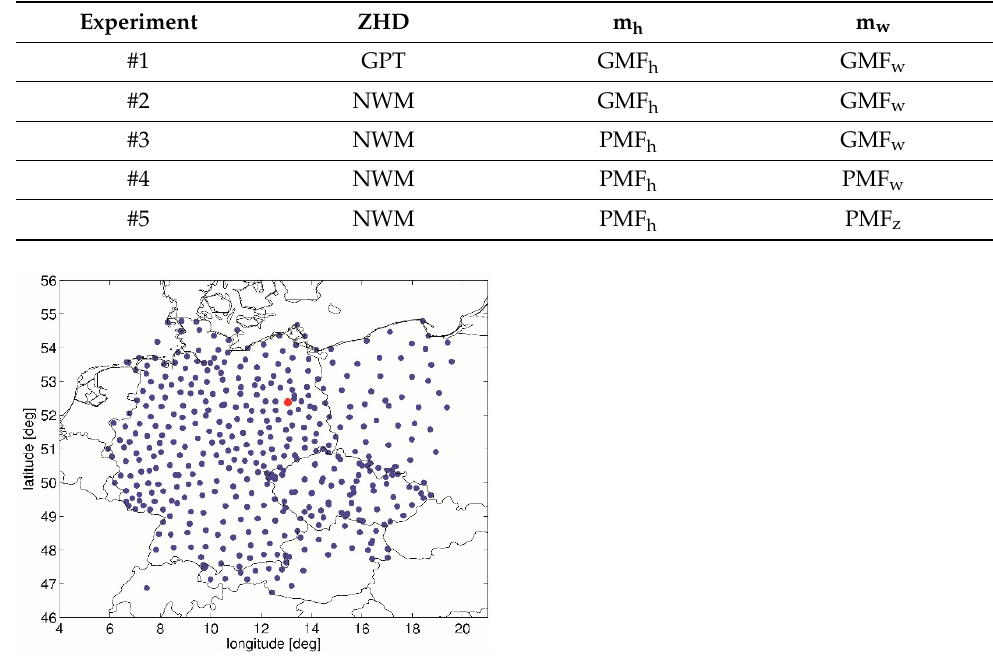
Figure 1. Map showing the locations of the stations in the simulation study. In total 431 stations cover the area of interest. The red dot indicates the location of the station POTS (Potsdam, Germany).